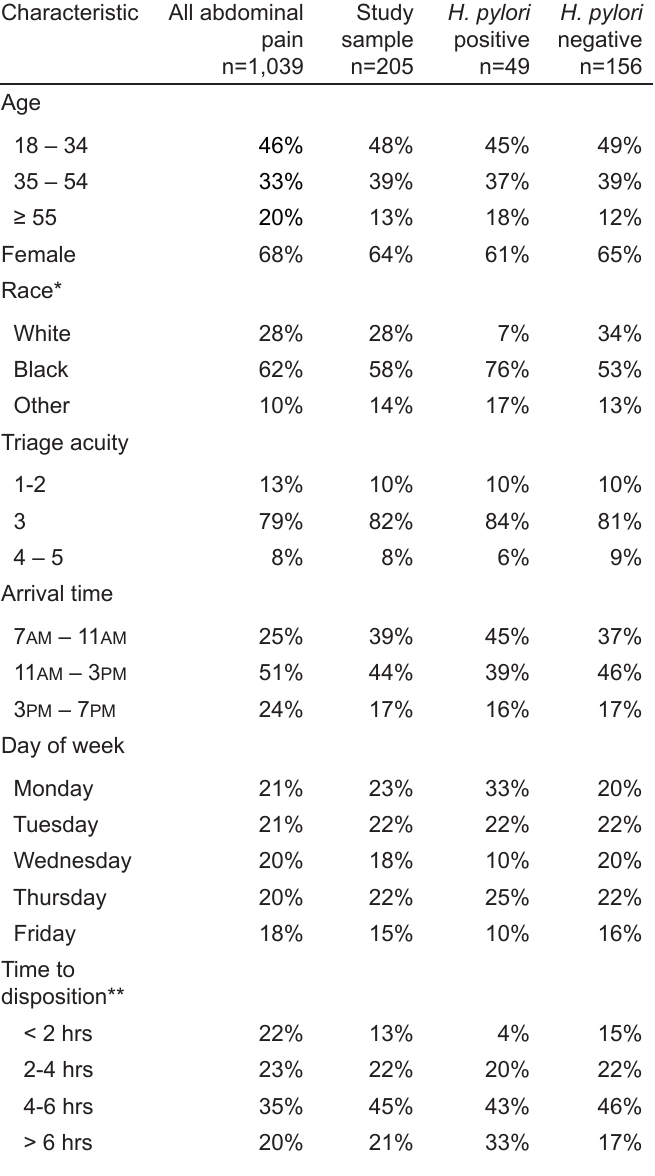
Table 1 . Percent distribution of all emergency department visits with abdominal pain compared to study sample by H. pylori